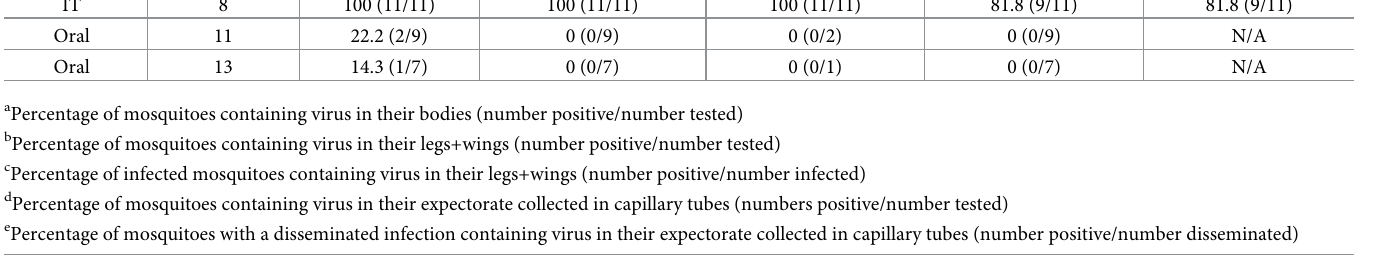
Table 3. Infection, dissemination and transmission rates of BgV in injected (IT) and bloodfed (oral) Cx . sitiens mosquitoes. Mode of